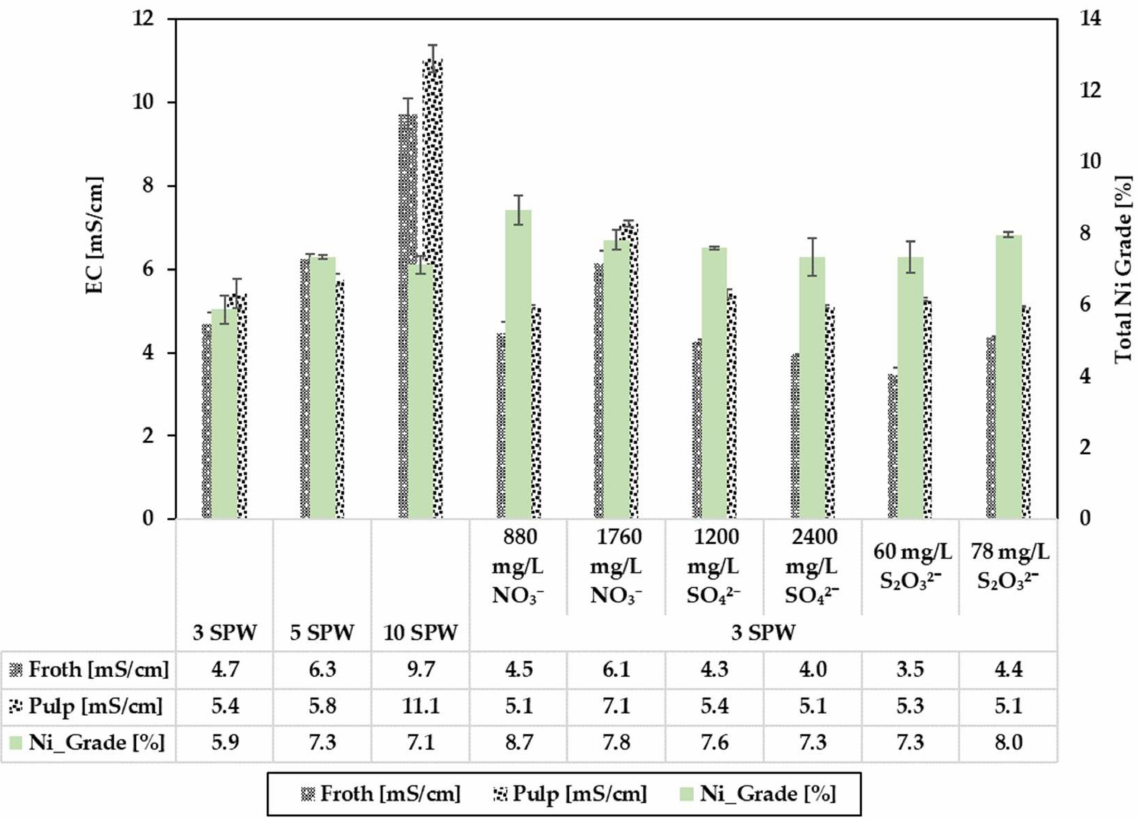
Figure 7. Relating the electrical conductivity to Ni